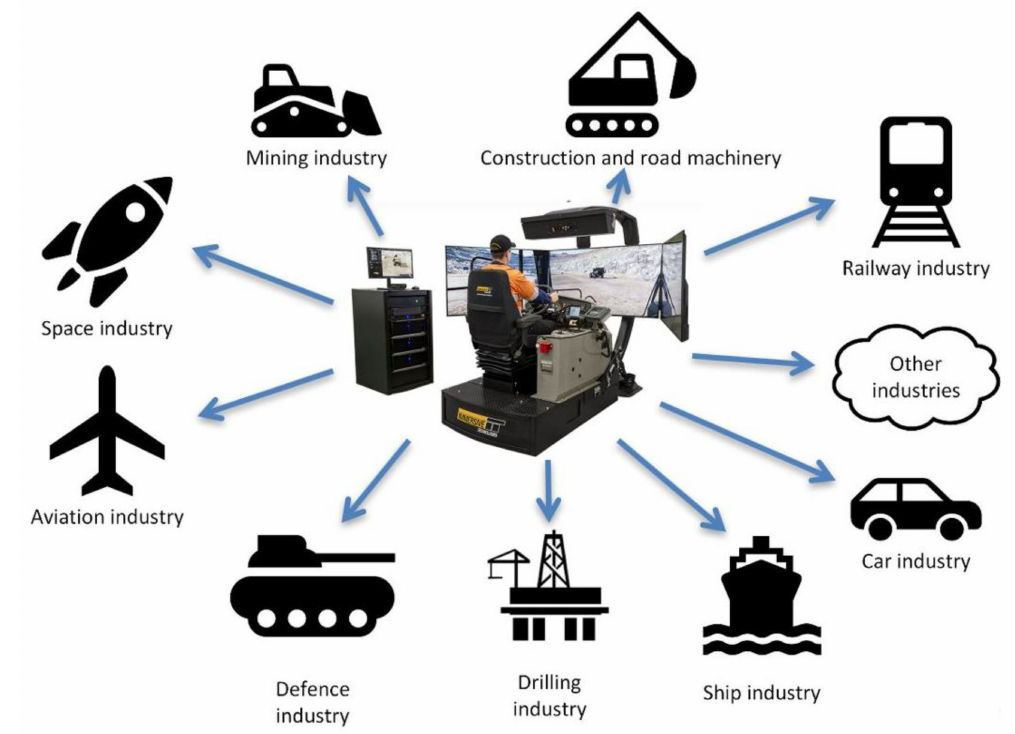
Figure 1. Major industries where simulators find application (based on